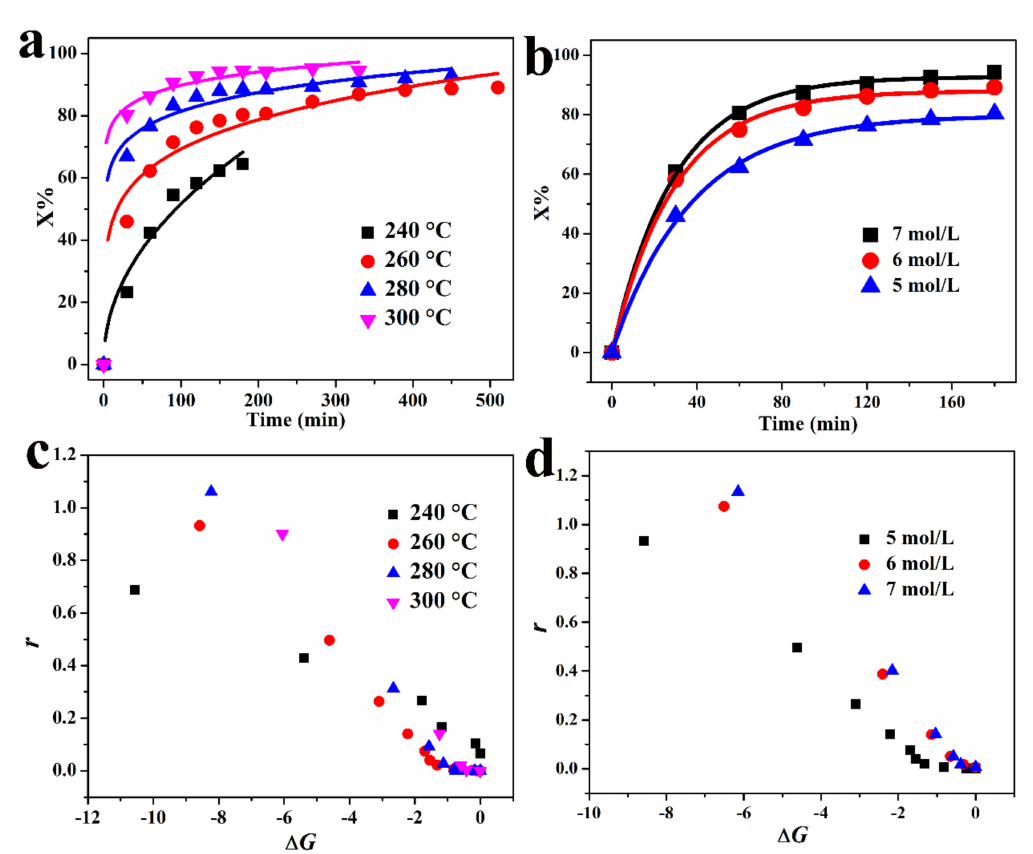
Figure 4. X -t relationship (a,b) and r- ∆ r G correlation ( c , d ) for reaction (R1) at different reaction temperatures and concentra- tions of